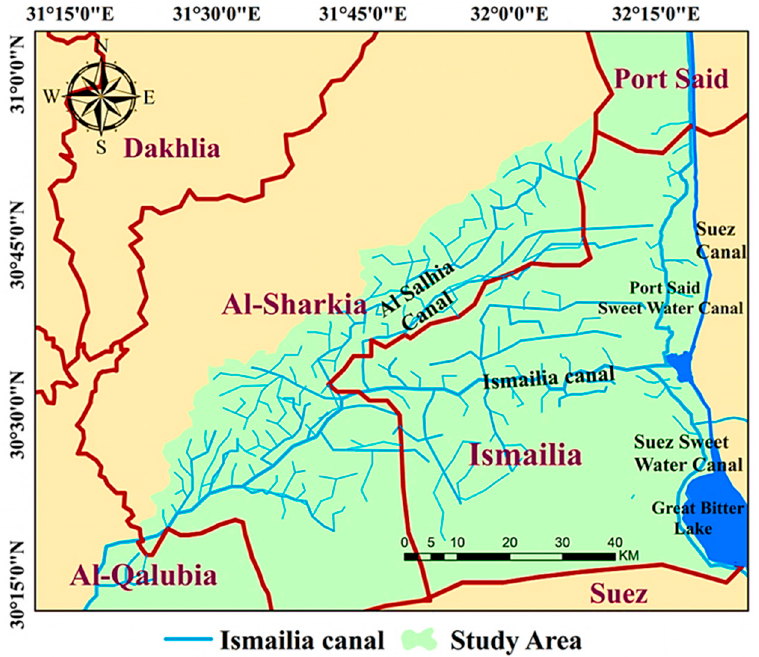
Figure 2. GIS map showing the study area.